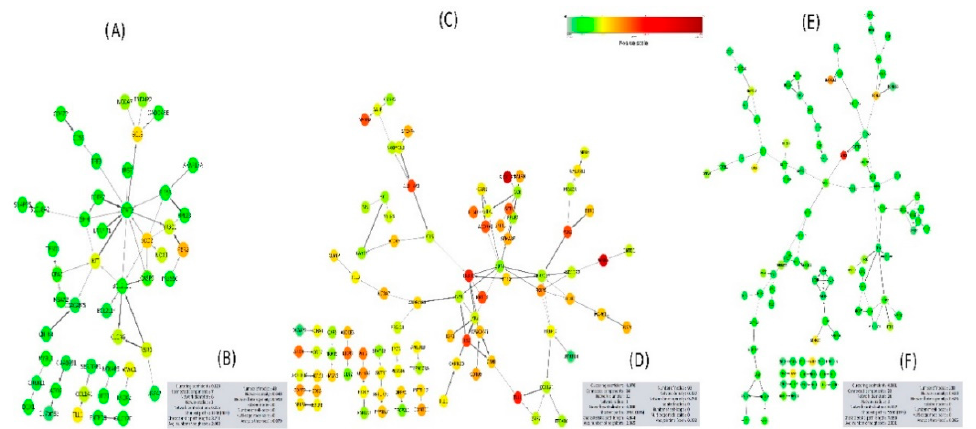
Figure 4. Protein–protein interaction (PPI) network interaction using STRING for moderate ( A ), severe ( C ) and ( E ) moderate-to-severe asthma phenotype using Cytoscape tool. Cytoscape network analysis was used to calculate the comprehensive set of topological parameters for moderate ( B ), severe ( D ) and ( F ) moderate-to-severe asthma phenotypes PPI networks (grey boxes). These parameters describe the degree of interaction and includes descriptive statistics such as the number of nodes, self-loops, and edges, the number of shortest paths, and the network radius, density, diameter, centralization, and clustering coefficient. See Cytoscape Network Analyzer Manual (http:/manual.cytoscape.org/en/stable/Network Analyzer.html) for more details. The confidence score for each interaction is linked to the thickness and opacity of the edge. The node color is associated with the asthma-association significance score of the DEGs.